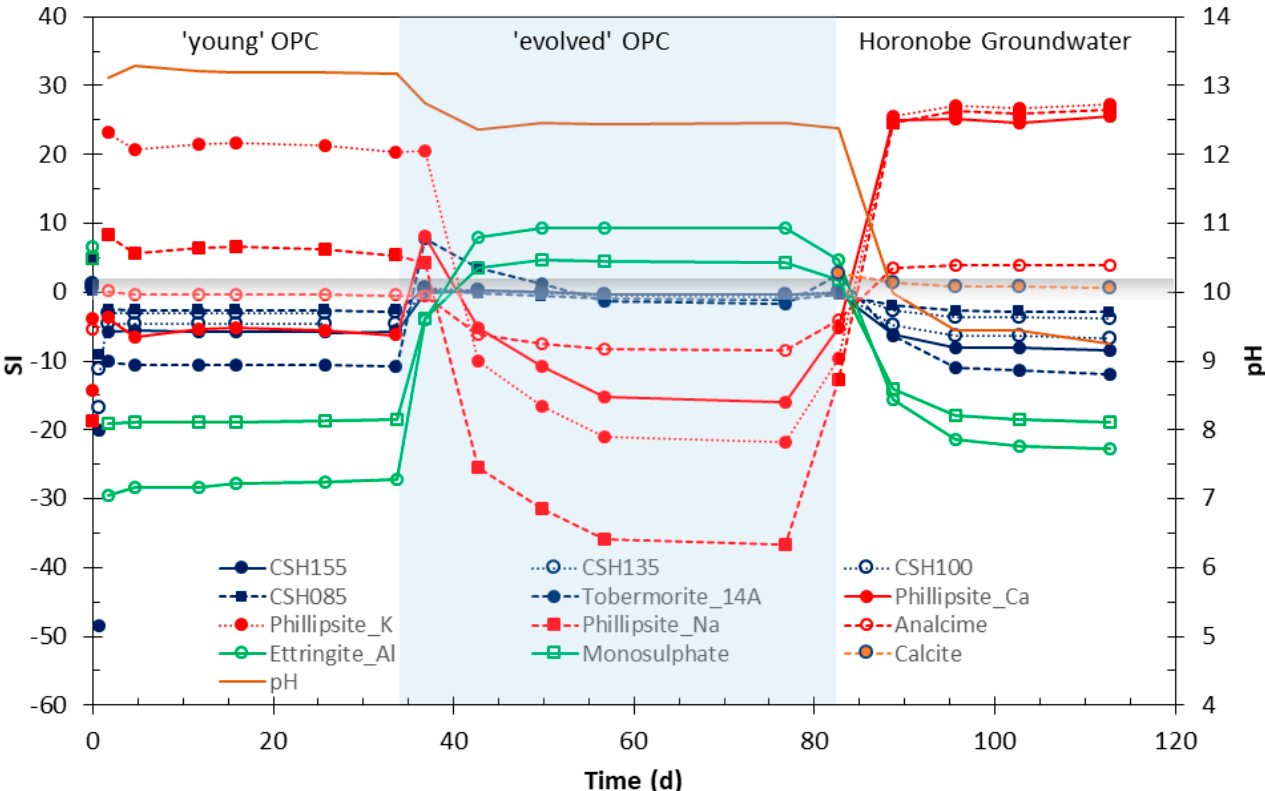
Figure 8. Selected secondary mineral saturation states in reacted fluids, experiment with ‘young’ OPC (Na-K-Ca-OH), and then the ‘evolved OPC leachate (Ca(OH) 2 ), followed by HGW; all data from SFC-3. Representative C-S-H phases in blue; zeolites in red; and S-bearing cement phases in green.